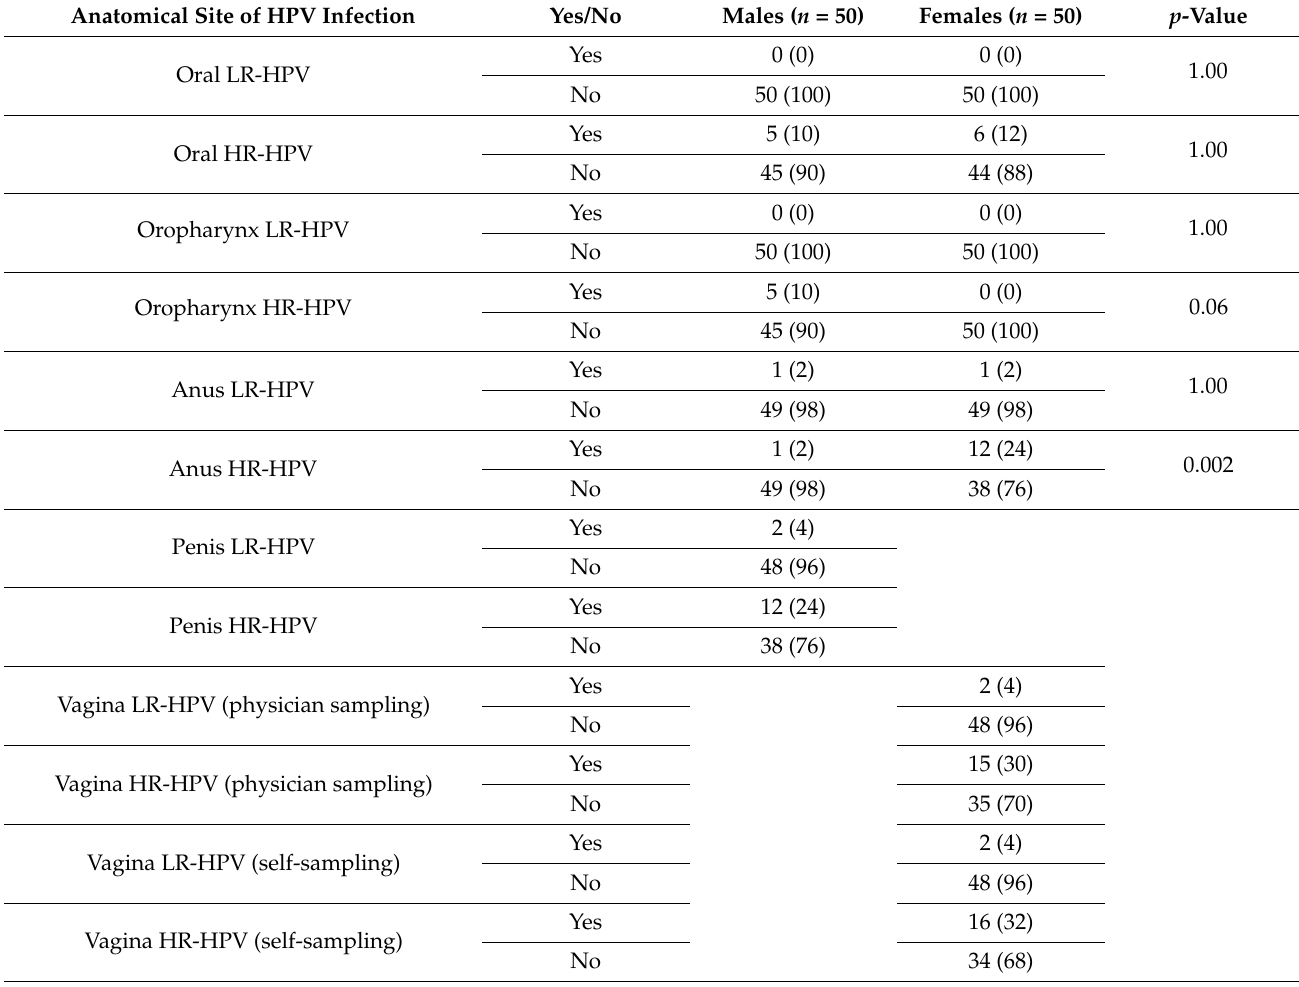
Table 3. Prevalence of HPVs in different mucous